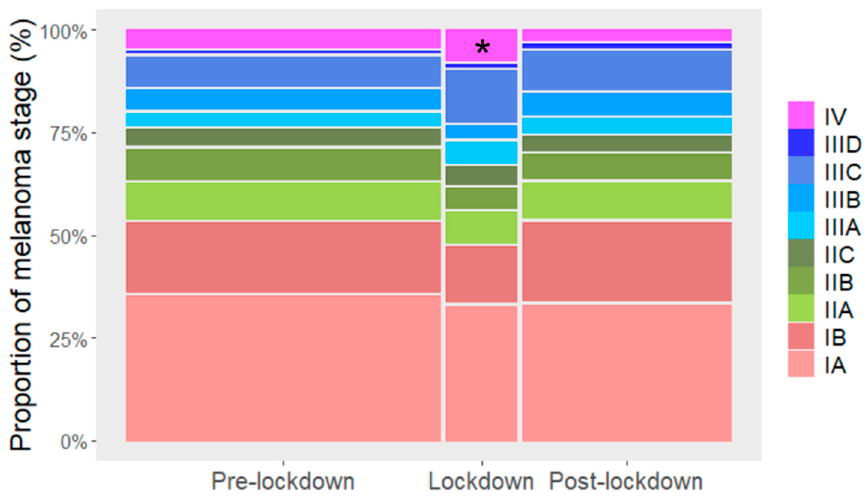
Figure 4. The proportion of the stages of diagnosed melanomas differed over time relative to the COVID-19 lockdown in Switzerland. The proportion of stage IV diagnosed melanomas was significantly higher during lockdown period (asterisk shows the cell with the largest residual). Chi-square test for stages grouped in I, II, III, and IV; p = 0.047).